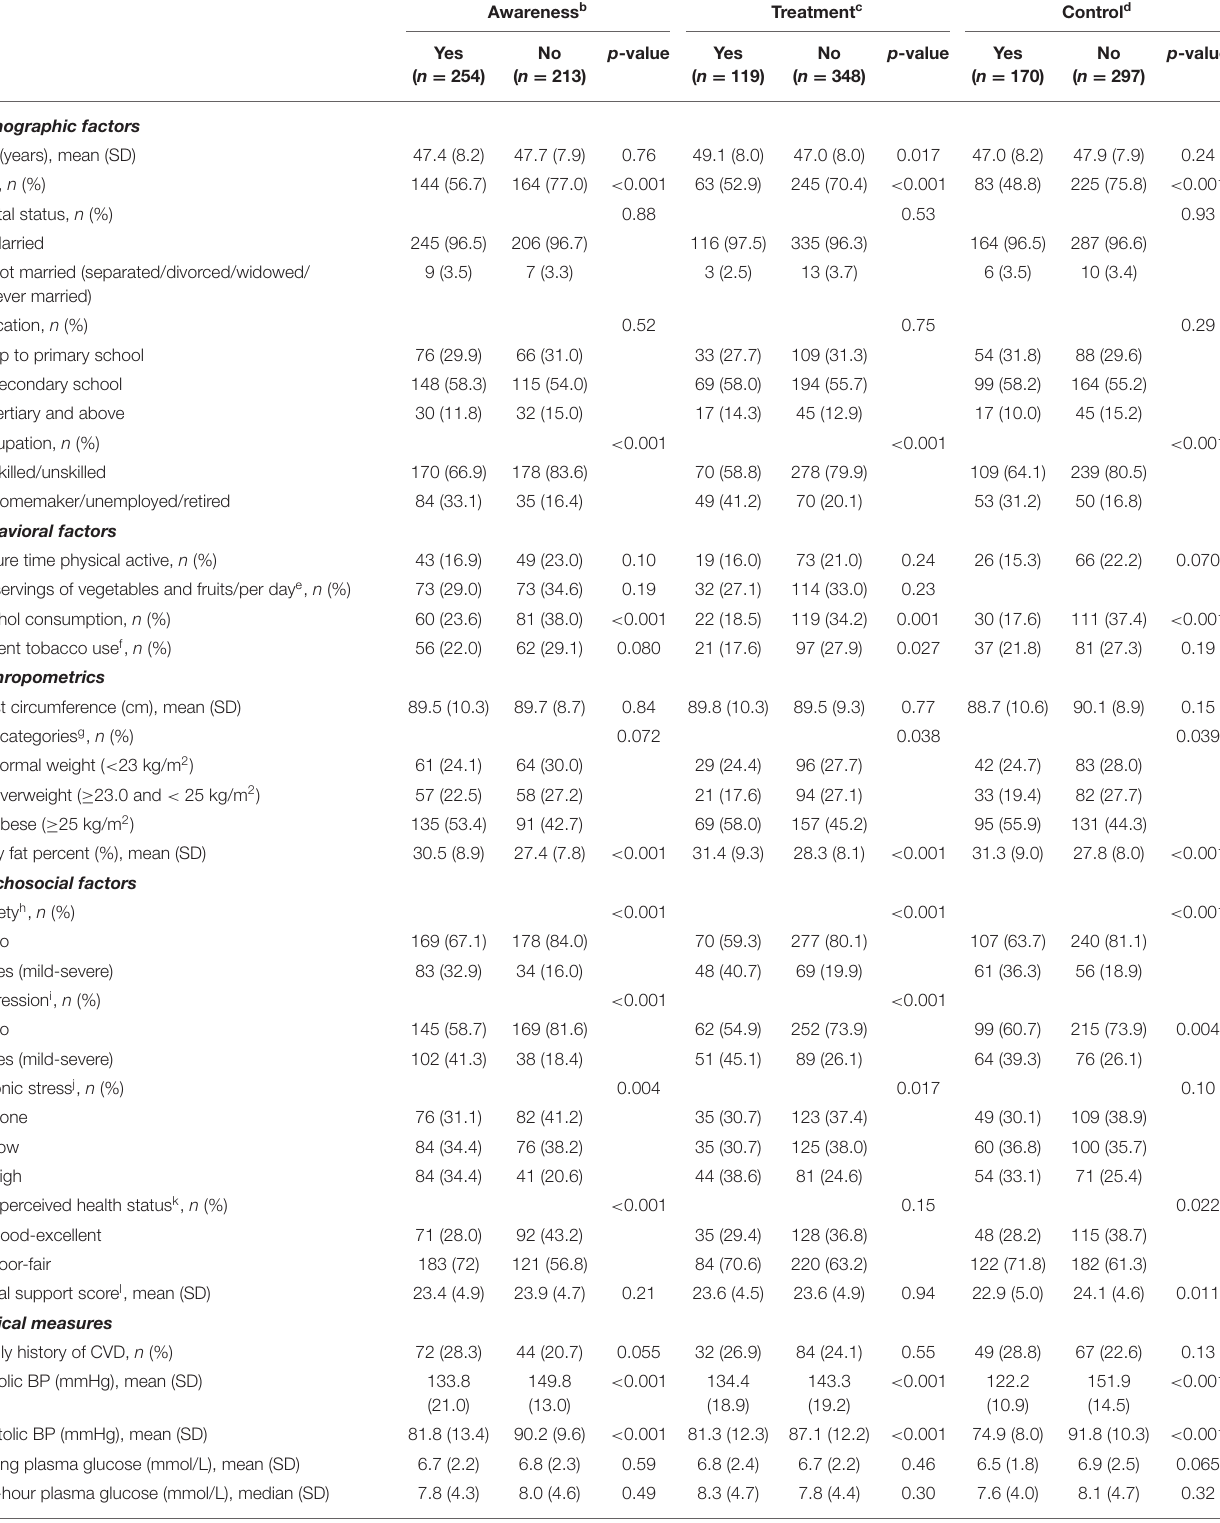
TABLE 3 | Characteristics of participants by hypertension awareness, treatment, and control groups among those with hypertension at baseline ( n = 467) a . Awareness b Treatment